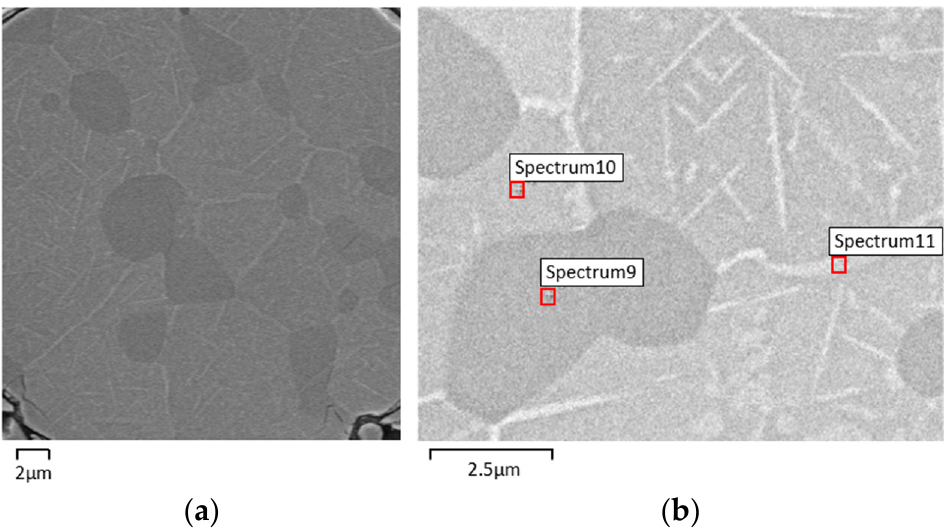
Figure 6. Micrographies of 3D object from filament B (addition of 1 wt.% TiH 2 ). ( a ) after sintering (SEM), ( b ) selected zones for evaluation of Ni:Ti ratio (S9, S10, and S11) by SEM/EDS. Table 7. Phases from filament B after sintering (Spectra 9, 10, and 11 in Figure 6b). Phase Composition (EDS)